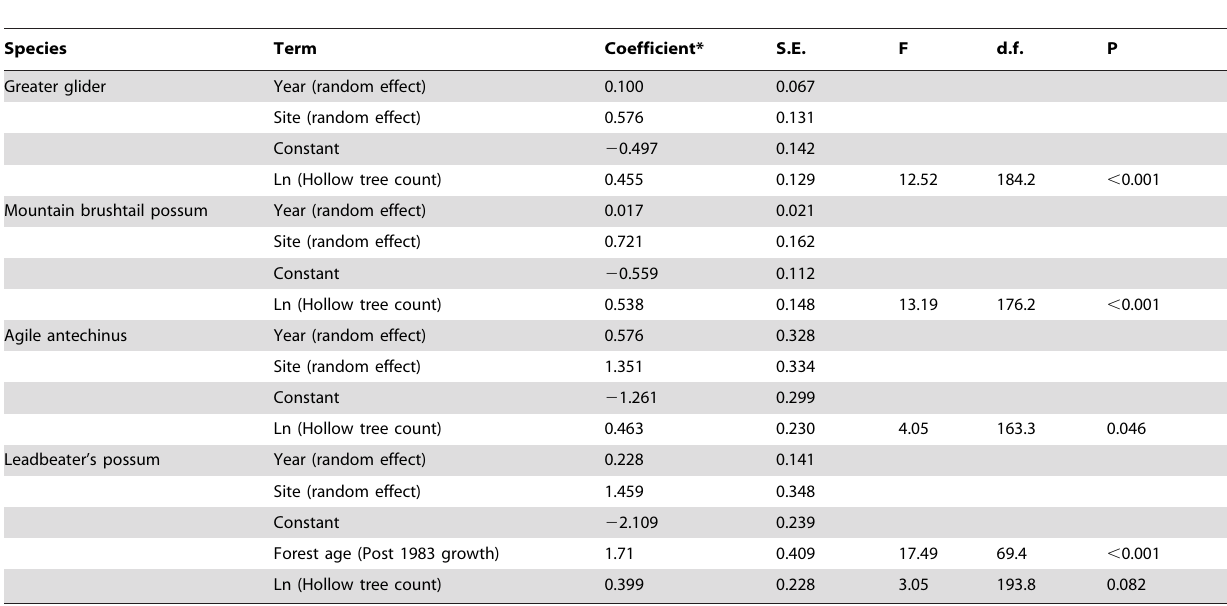
Table 1. Poisson generalised linear mixed models of the effects of hollow tree availability and forest age (non-significant terms were dropped from models) on the abundance of four species of arboreal